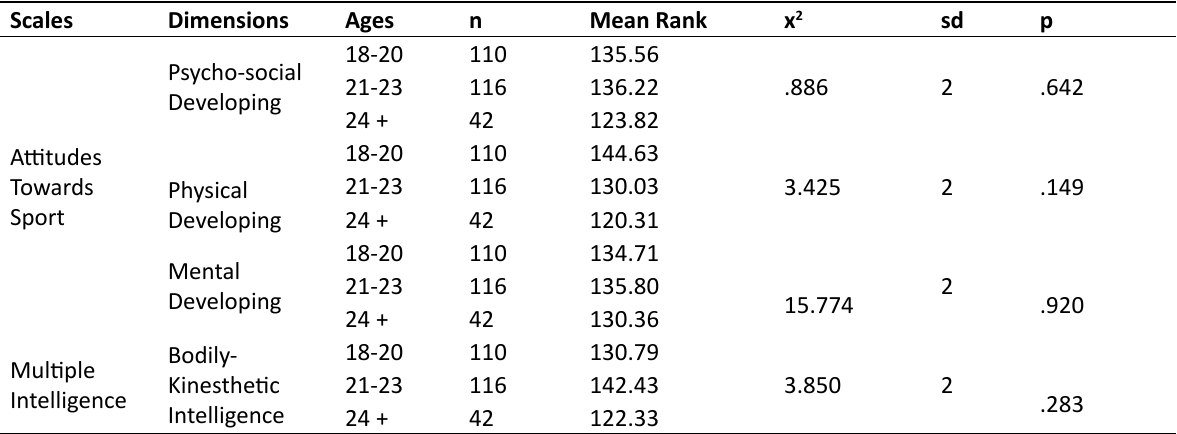
Table 4. Evaluation of the students’ attitudes towards sport and bodily-kinesthetic intelligence by university. Scales